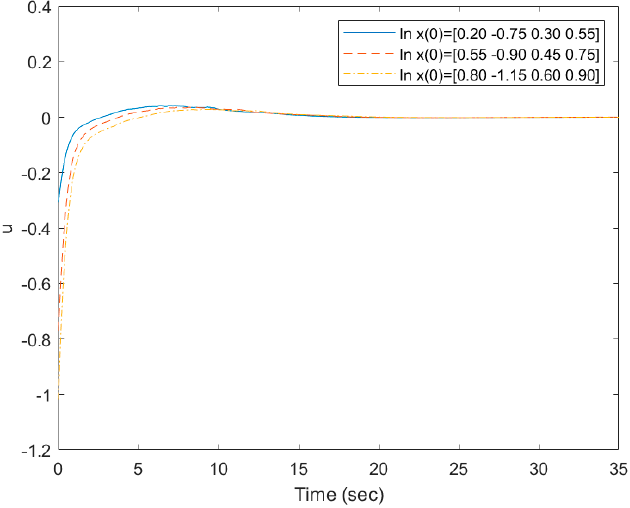
Figure 6. Response of u ( t )